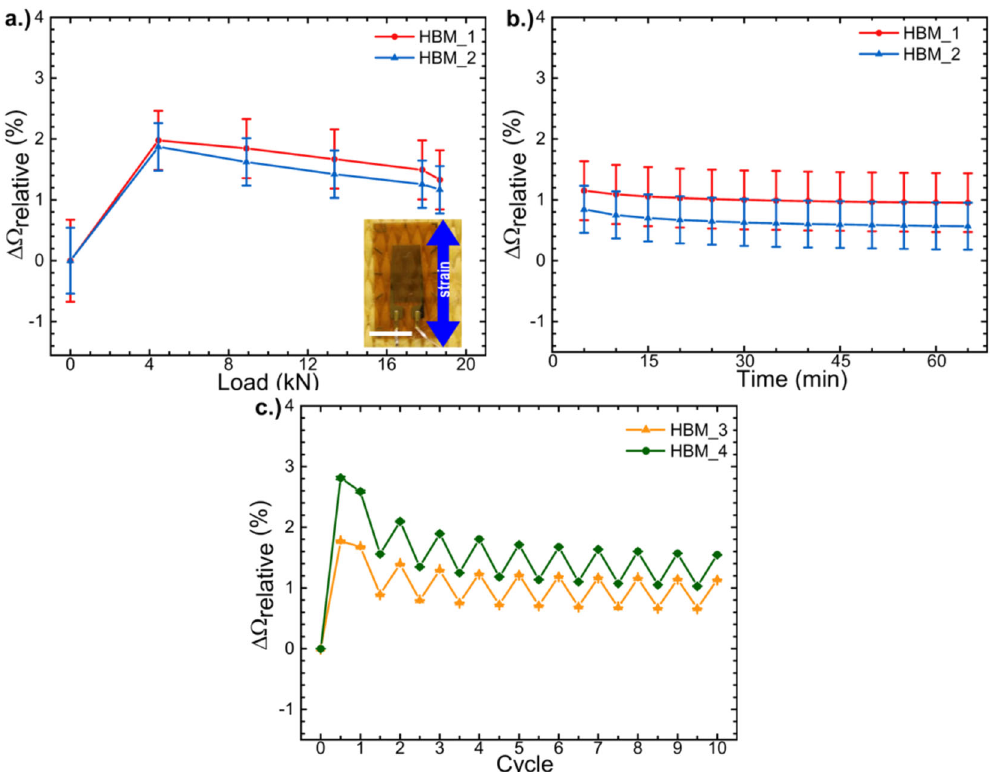
Fig. 5 Strain response for commercial resistance-based strain gauges. The strain response of commercial RSGs having their electrodes arranged parallel to the direction of strain during a dynamic testing with a ramp of 44.5 N/sec, b static testing at a load of 18.7 kN and c cyclic testing utilizing loads of 5.3 kN and 10.7 kN. Error bars are the estimated experimental uncertainty (Supplementary Discussion). Scale bar represents 4.0